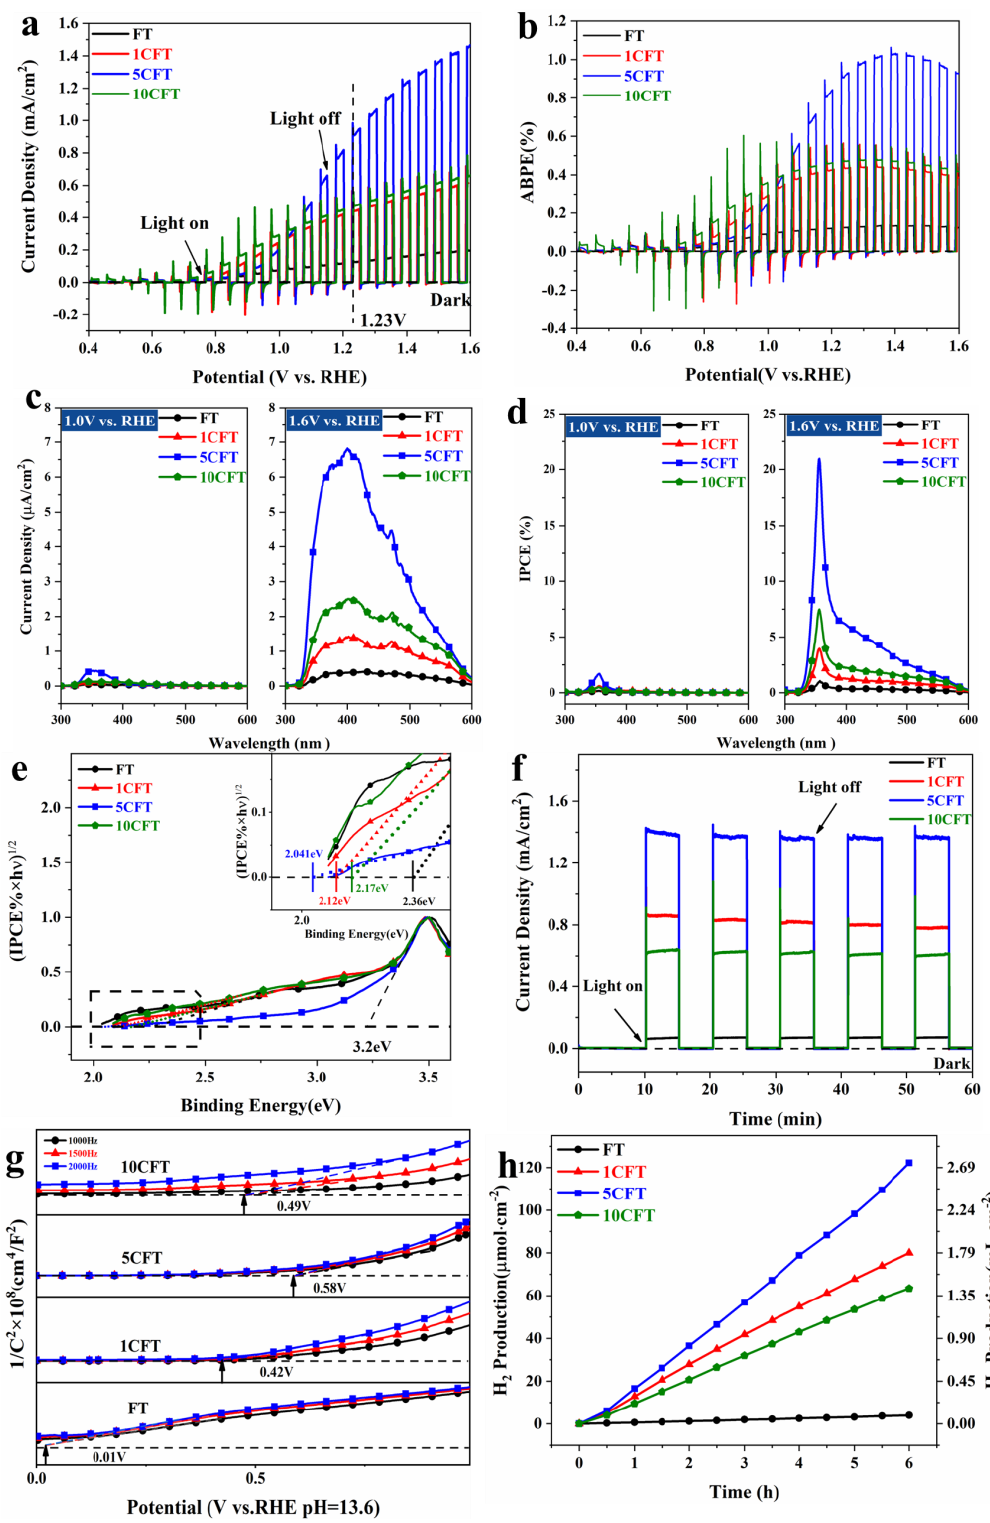
Figure 4. Photoelectrochemical performance of Fe 2 O 3 (FT) and Ce-doped Fe 2 O 3 (1CFT, 5CFT, 10CFT) ; ( a ) linear sweep voltammetry ( b ) ABPE ( c ) Photocurrent density versus the monochromatic light ( d )